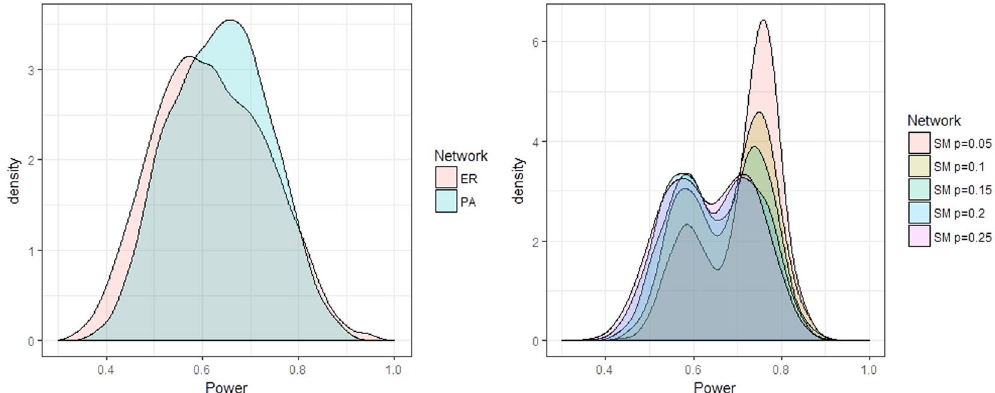
Figure 3. Density of node Power for random ER, Small World and PA-networks.